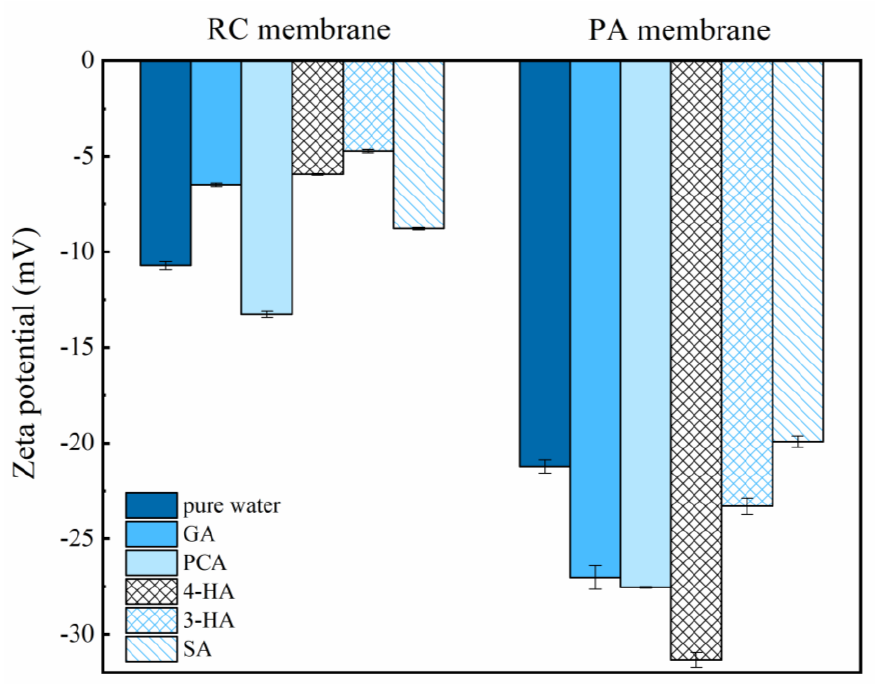
Figure 4. The water contact angle of RC and PA membrane after soaking in pure water and phenolic acids for 2 h. Experimental conditions: feed concentration = 10 mM and 25 ± 2 °C.